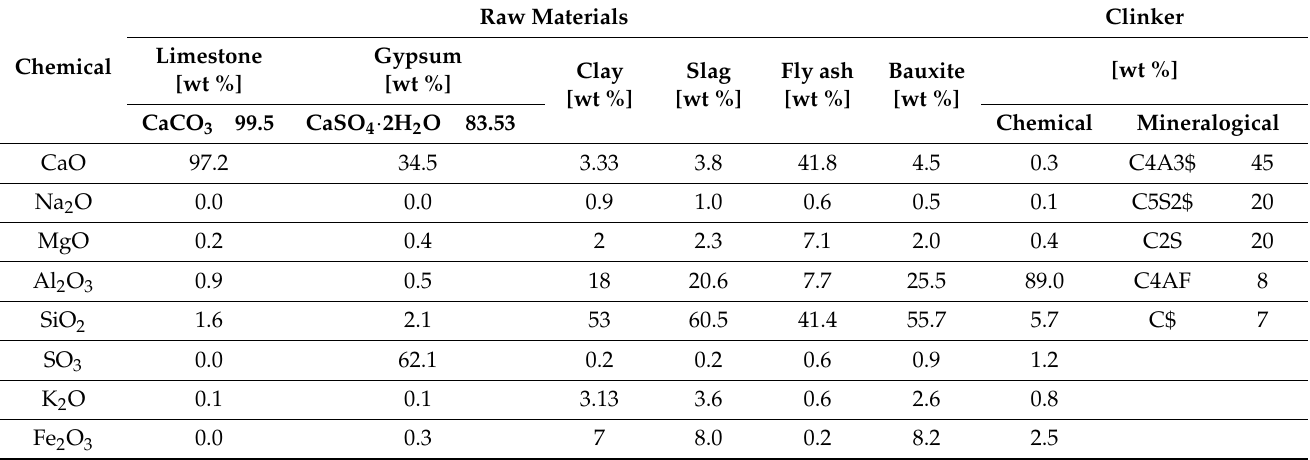
Table 1. Chemical compositions of raw materials used, and the designed mineralogical composition of CSA. Raw Materials Chemical